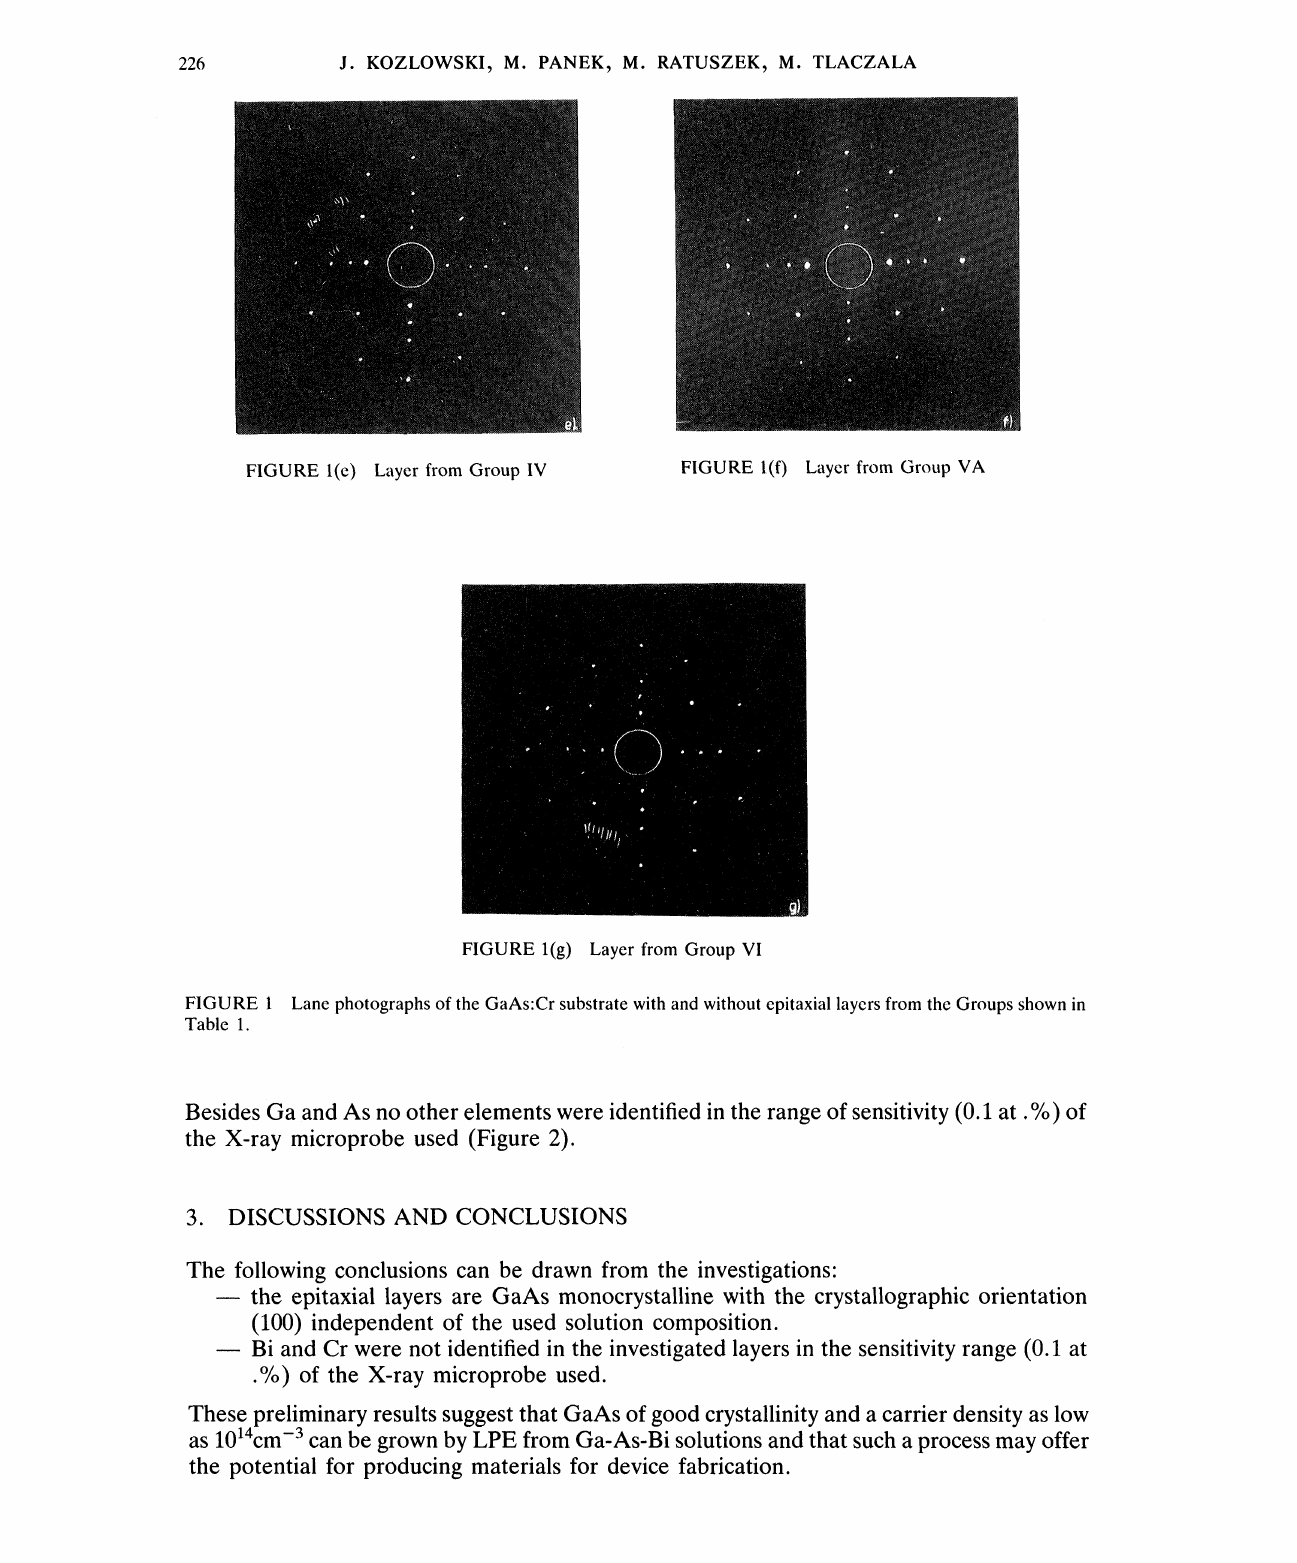
Lane photographs of the GaAs:Cr substrate with and without epitaxial layers from the Groups shown in Table 1.